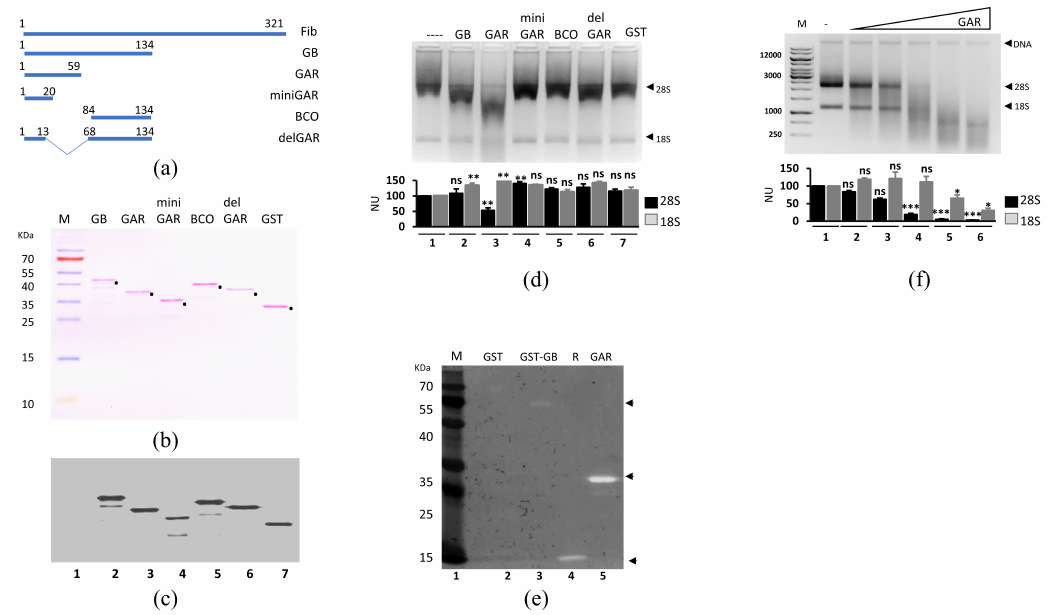
Figure 4. The GAR domain of fibrillarin is a modular domain with RNA activity. ( a ) Schematic representation of small peptides expressed from GB. ( b ) Ponceau staining of the HsGB small peptides expressed. All peptides were fused to the GST and 6 His tags. The band corresponding to the expected peptide is shown by a dot. (c) Anti-6xHis antibody was used to identify each peptide by Western blot. ( d ) RNA assay from the purified peptides. Under the same conditions, the GST-GAR domain has higher activity than the GST-GB domain (Lanes 2 and 3). The other peptides (miniGAR, BCO, and delGAR) have no activity. GST was used as a negative control. ( e ) In-gel RNAse assay of fibrillarin GB domain (amino acids 1 to 134). Degradation of RNA is higher when GST was cleaved from the GAR domain (Lanes 3 and 5). GST and RNAse A (R) were used as negative and positive controls, respectively. ( f ) RNA activity assay of the GAR domain. rRNA degradation is directly proportional to the amount of the GAR domain. ( d , f ) Quantification of 28S and 18S signals were made by ImageJ software and statistical significance was determined by t -test (* p -value < 0.05; ** p -value < 0.01; *** p -value < 0.001, ns = not significant p -value > 0.05) and plots are indicated below the gels from n =